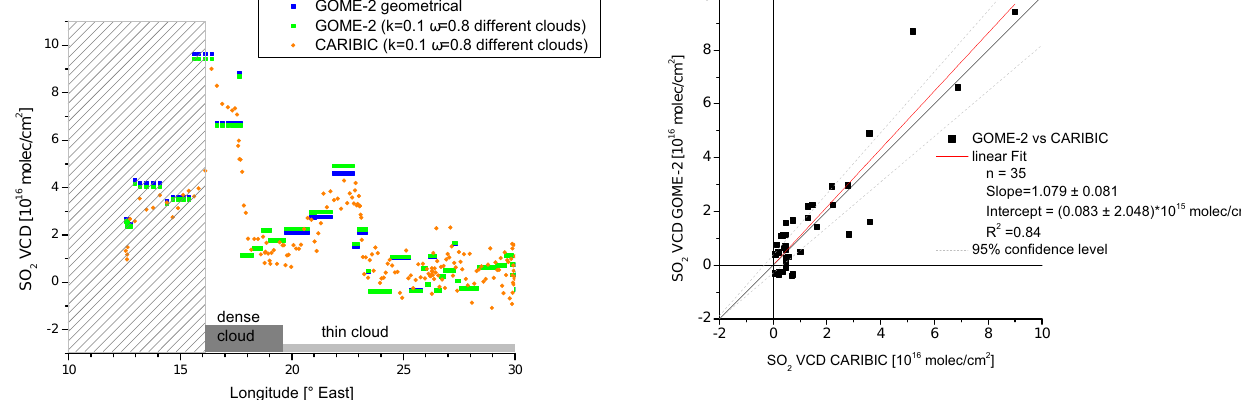
Fig. 16. Correlation plot of SO 2 vertical columns observed by GOME-2 vs. averaged CARIBIC values. Only data where the aero- plane was clearly above the cloud are considered here (cf. Fig.